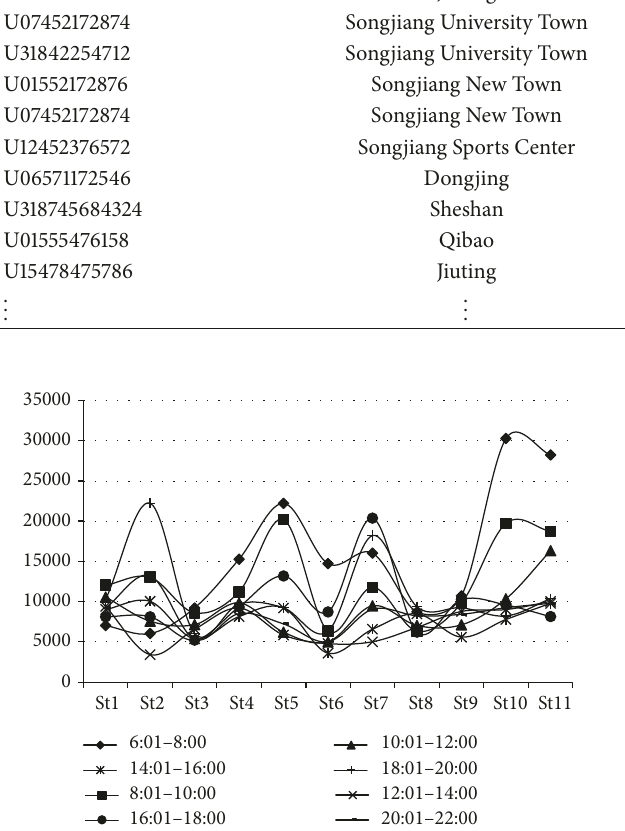
Figure 3: The aggregation passenger flow based on distribution